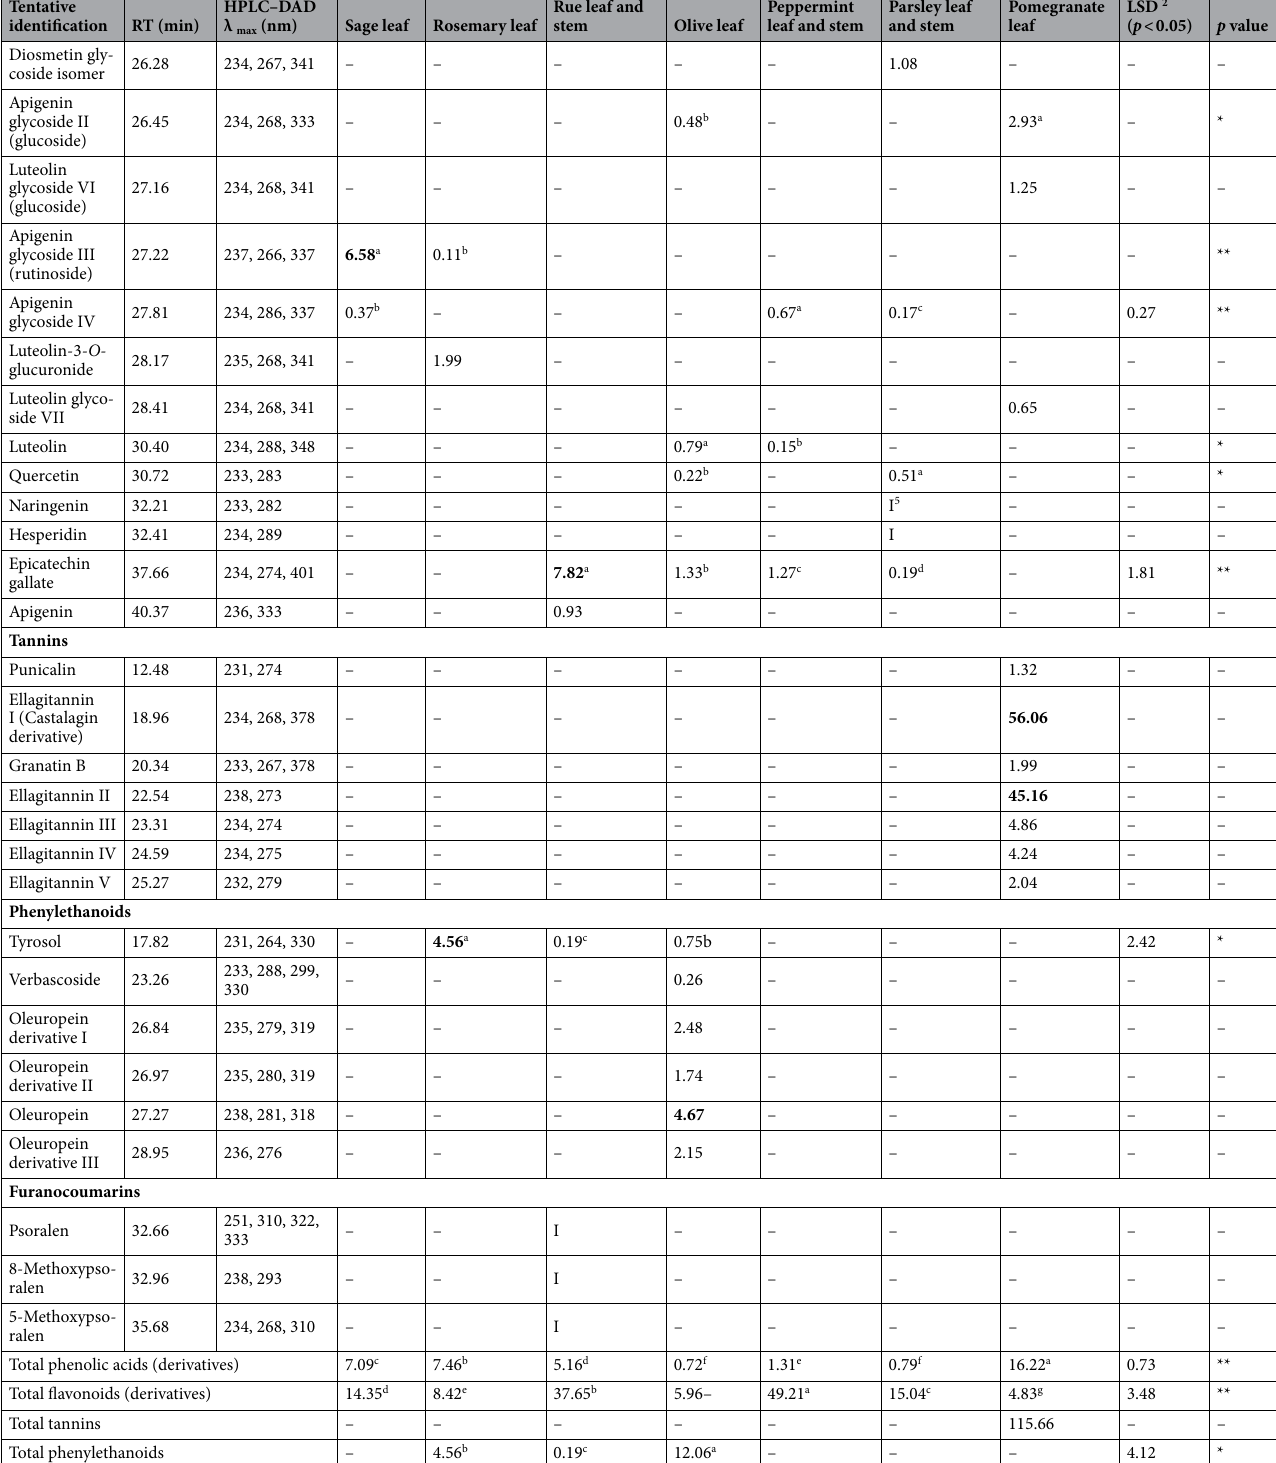
Table 2. Phenolic profiles of the studied plants and concentrations of their identified compounds (mg g −1 DW of plants). 1 Concentrations of individual phenolics are expressed as milligram per gram of plant dry